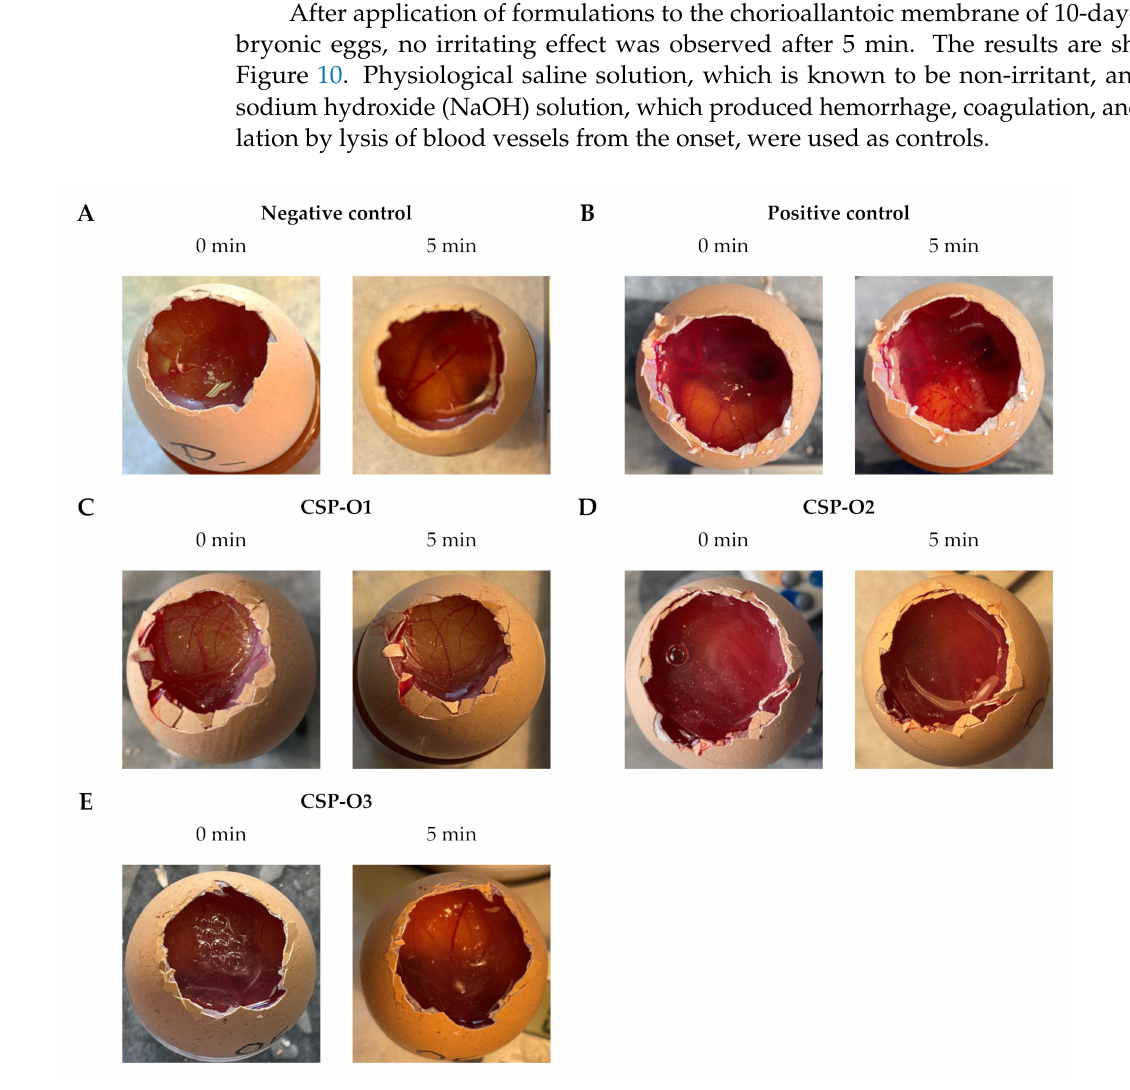
Figure 10. Results of the HET-CAM test: ( A ) physiological saline solution as the negative control; ( B ) NaOH 0.1 N as the positive control; ( C ) CSP-O1 formulation; ( D ) CSP-O2 formulation; and ( E ) CSP-O3